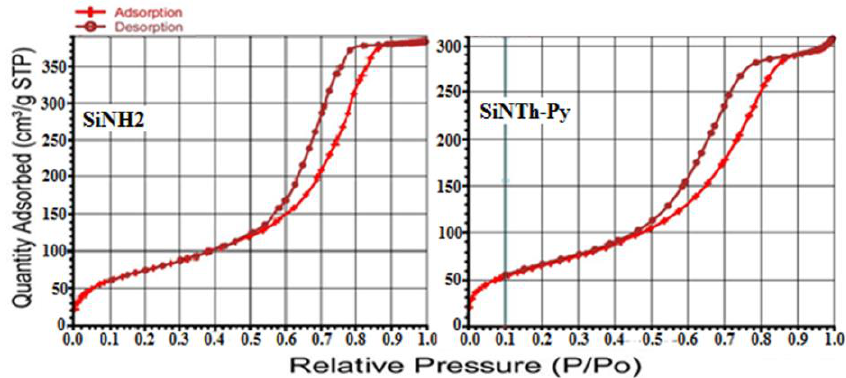
Figure 4. 13 C-NMR spectra of (SiNH 2 ) and (SiNTh-Py).